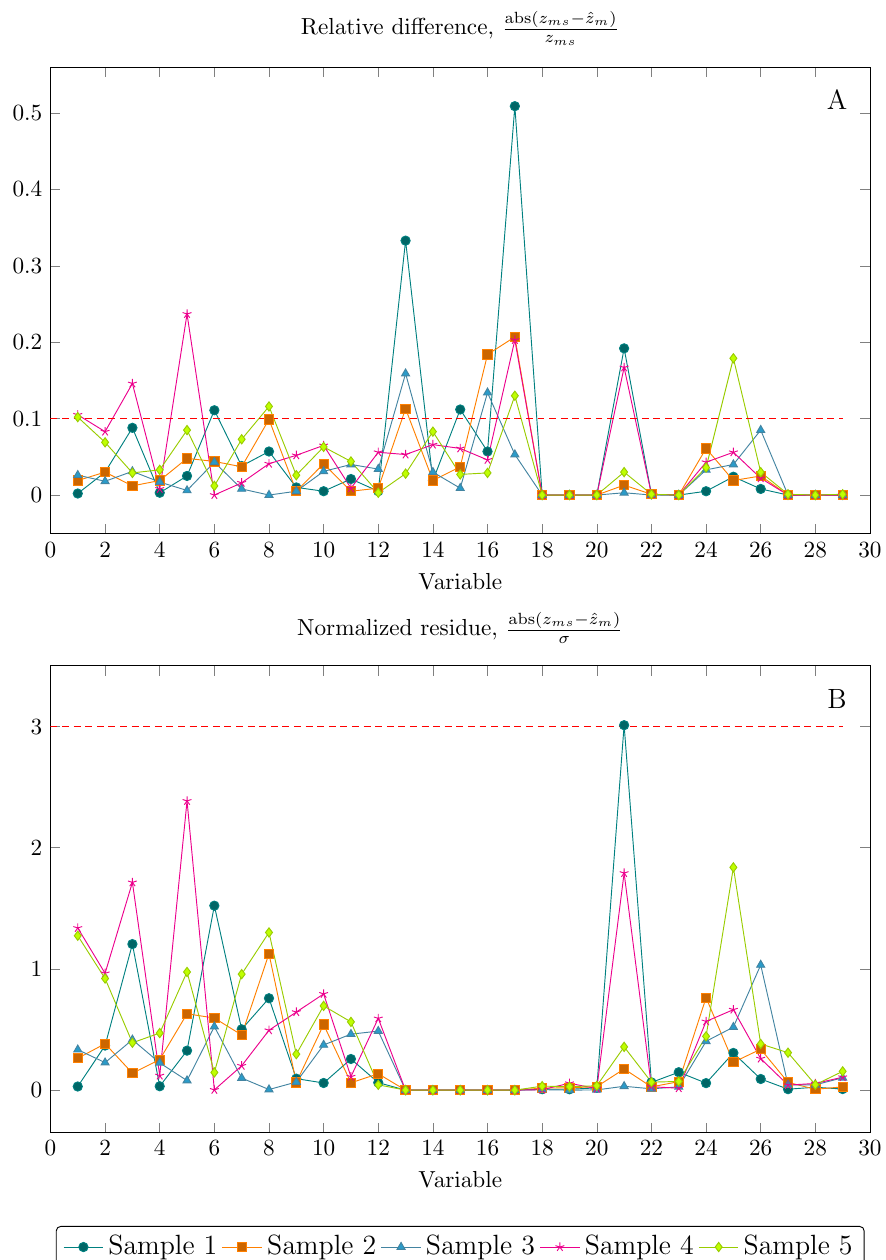
Figure 5. Comparison of metrics for assessing reconciled results: ( A ) Relative difference between measured and reconciled data; ( B ) Normalized residue. DR results of setting